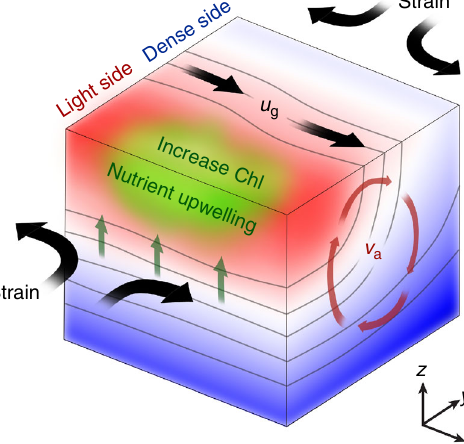
Fig. 3 Strain-induced frontal processes in the Northern Hemisphere. A mesoscale front exists along the x -direction with dense (light) water present in positive (negative) y direction. In the Northern Hemisphere, the along-front geostrophic velocity u g is pointed to the positive direction of x . Due to the background geostrophic strain fi eld stretching along the front and compressing across the front, the cross-front density gradient is enhanced by the strain fi eld. As the cross-front density gradient enhances, frontal instabilities develop causing release of available potential energy of the front and restrati fi cation. The resulting net effect sustains a cross-front ageostrophic secondary circulation in the y – z plane as indicated by v a . The secondary circulation causes upwelling/downwelling along the light/dense side of the front, generating upward nutrient fl uxes and a chlorophyll increase along the light side of the